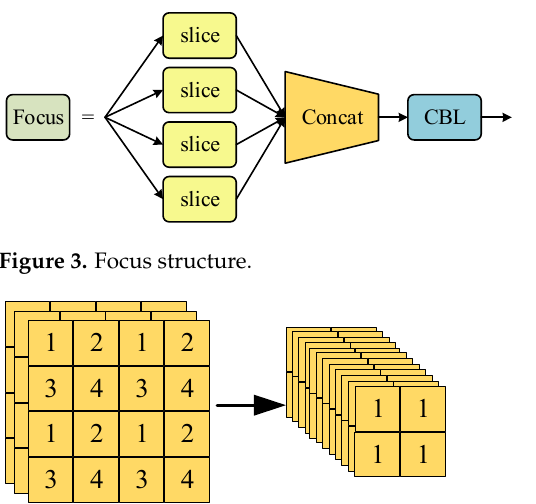
Figure 4. Slice operation.